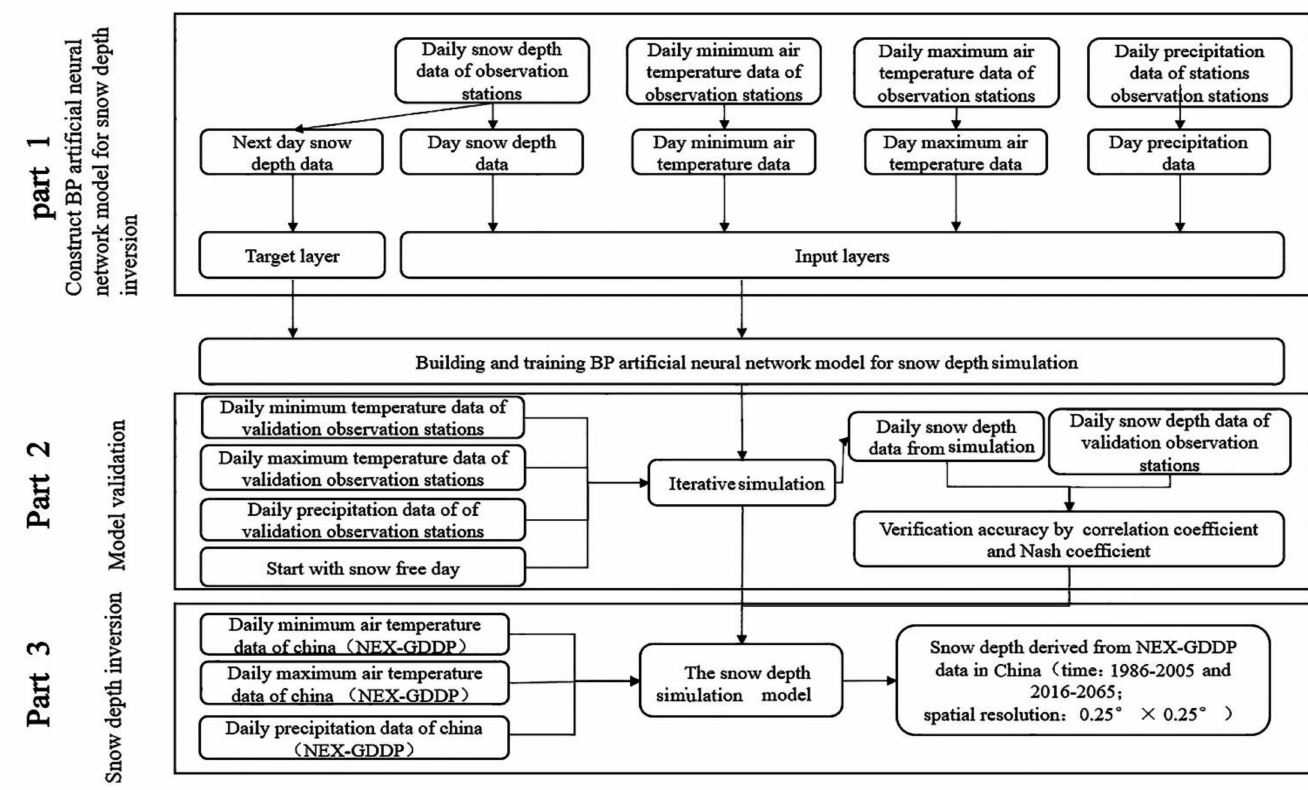
Figure 3. Technology process.